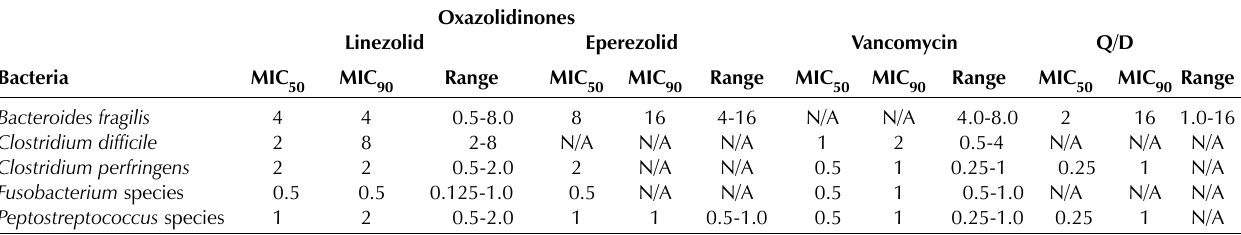
In vitro activity of oxazolidinones vancomycin and quinupristin/dalfopristin (Q/D) against anaerobes